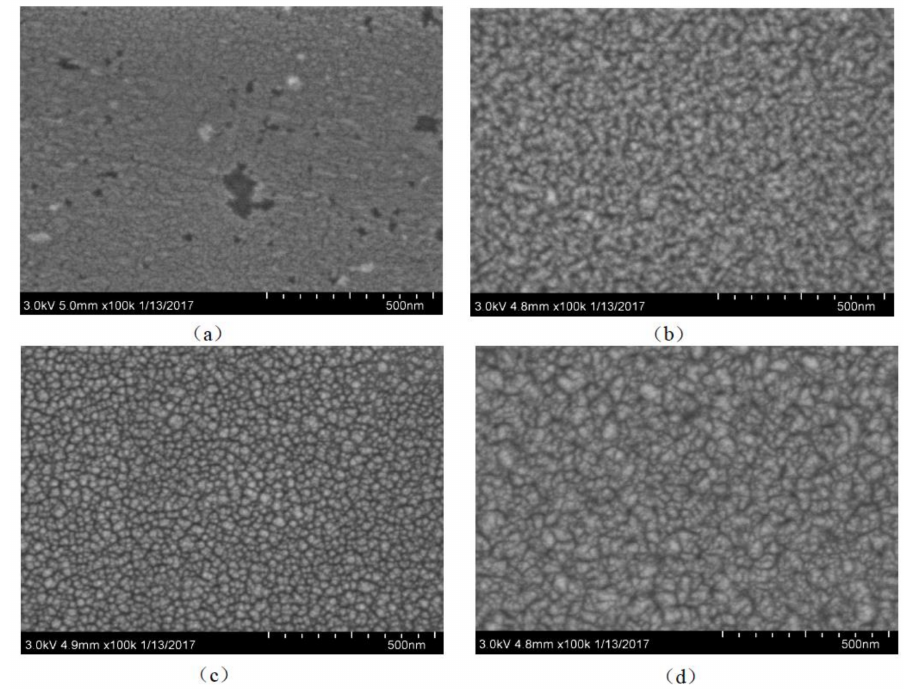
Figure 7. Scanning electron microscope (SEM) images of the Li-doped ZnO thin films under different sputtering powers: ( a ) 140 W; ( b ) 180 W; ( c ) 220 W; ( d ) 260